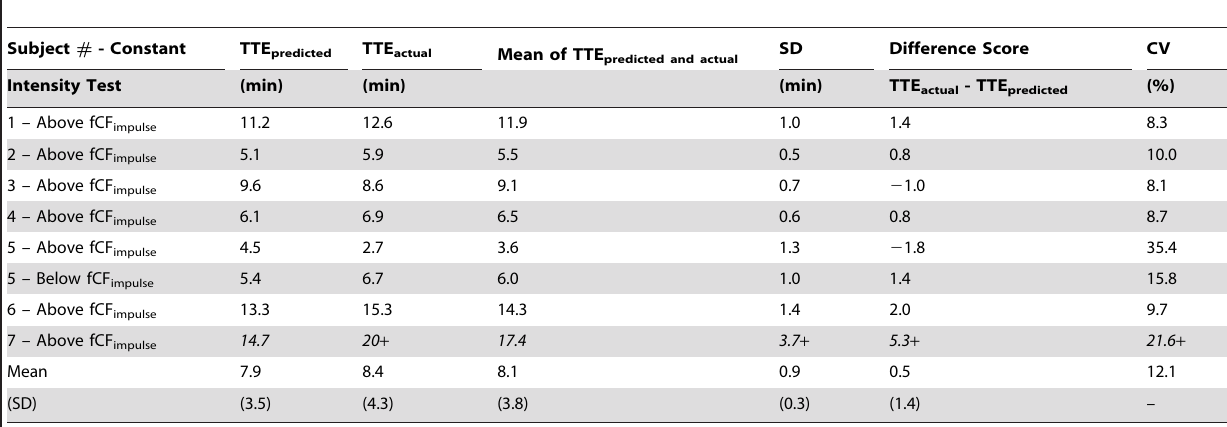
Table 4. Predicted and actual time to exhaustion (TTE) for constant intensity exercise tests where subjects ended up exercising above fCF impulse .